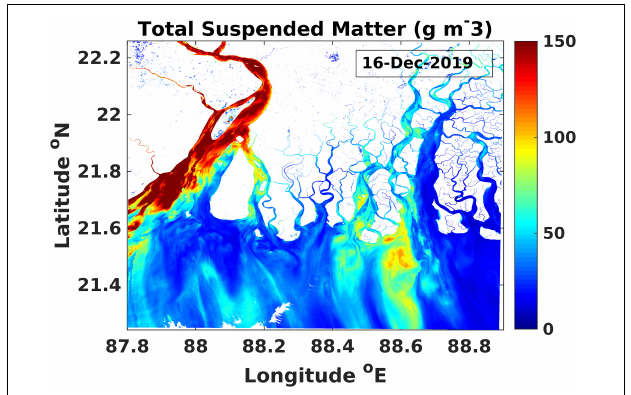
variability of TSM anomaly for the month of April during 2016– 2019 is shown in Figure 5 . The spatial distribution pattern of